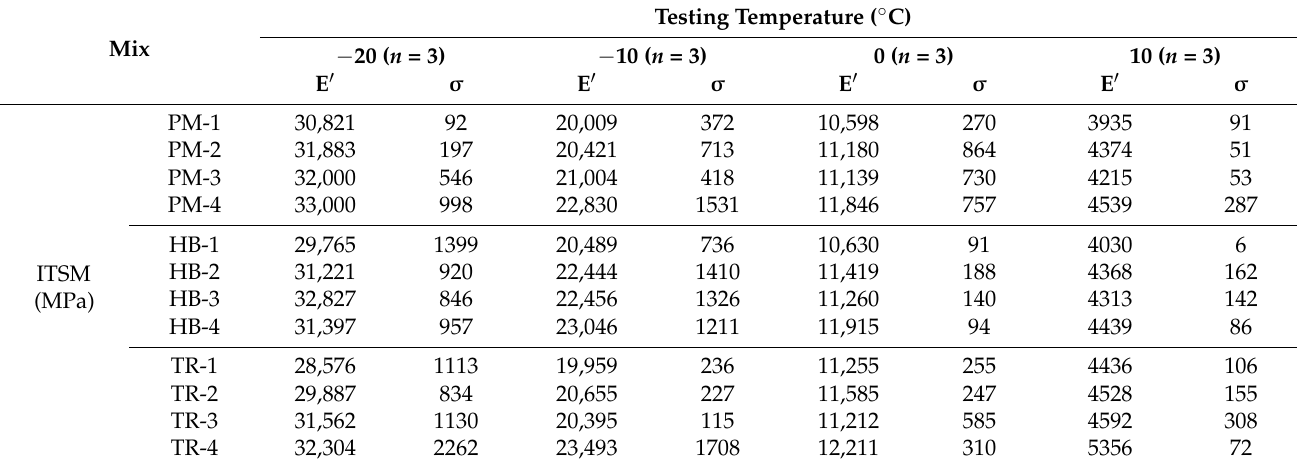
Table 8. ITSM results at − 20, − 10, 0, and 10 ◦